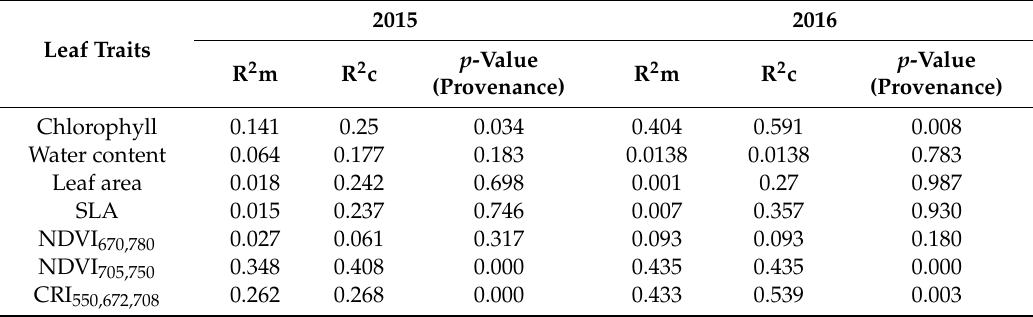
Figure 7. Reflectance indices: ( a ) NDVI 670, 780 2015; ( b ) 2016; ( c ) NDVI 705, 750 2015; ( d ) 2016; and ( e ) CRI 550, 672,708 2015; ( f ) 2016; bar chart ( n = 9–11 for 2015 and n = 3 for 2016). Significant effects for genotype within the provenance (G) and provenance (P) tested by linear mixed model with P as a fixed factor and G as random factor (significant p values are denoted as *** ( p < 0.001). Table 1. Linear mixed model of leaf traits with provenance as fixed factor and genotype within provenance as random factor. R 2 m, variance explained only by fixed factor and R 2 c conditional variance explained by both fixed and random factors (significant p values ( p < 0.05) are represented in bold).